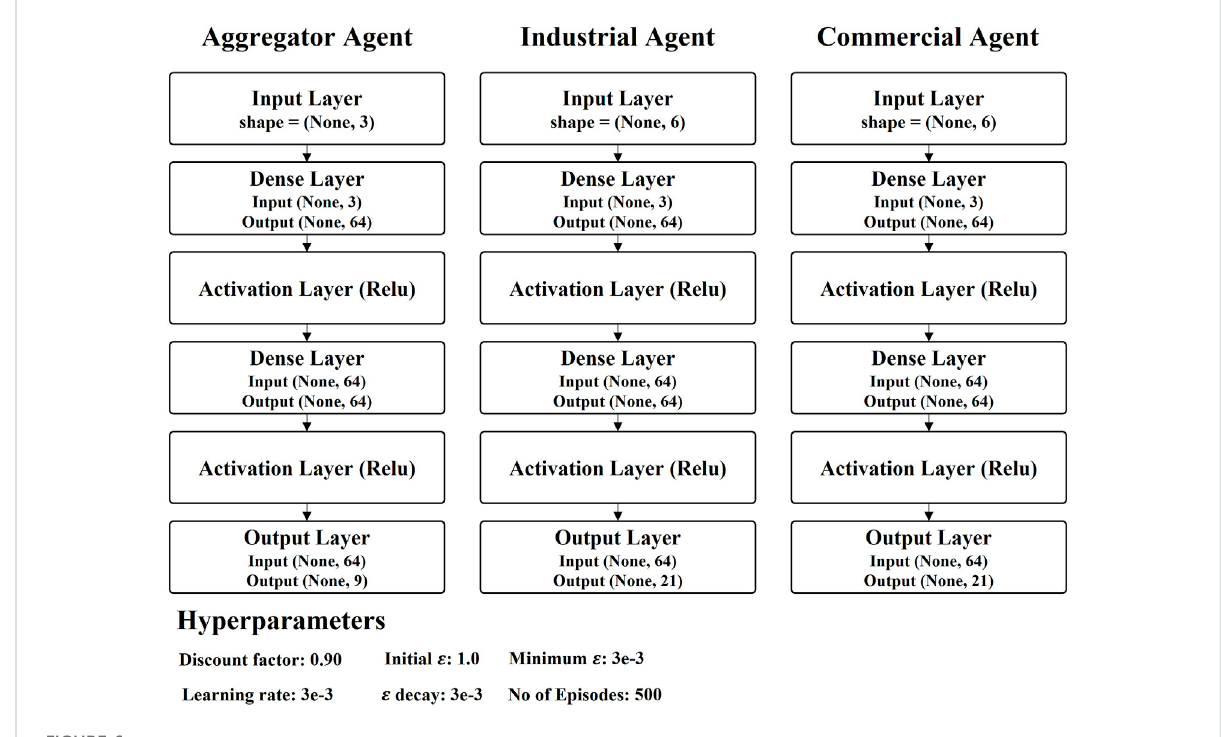
FIGURE 6 DQL agent structure and hyperparameters.